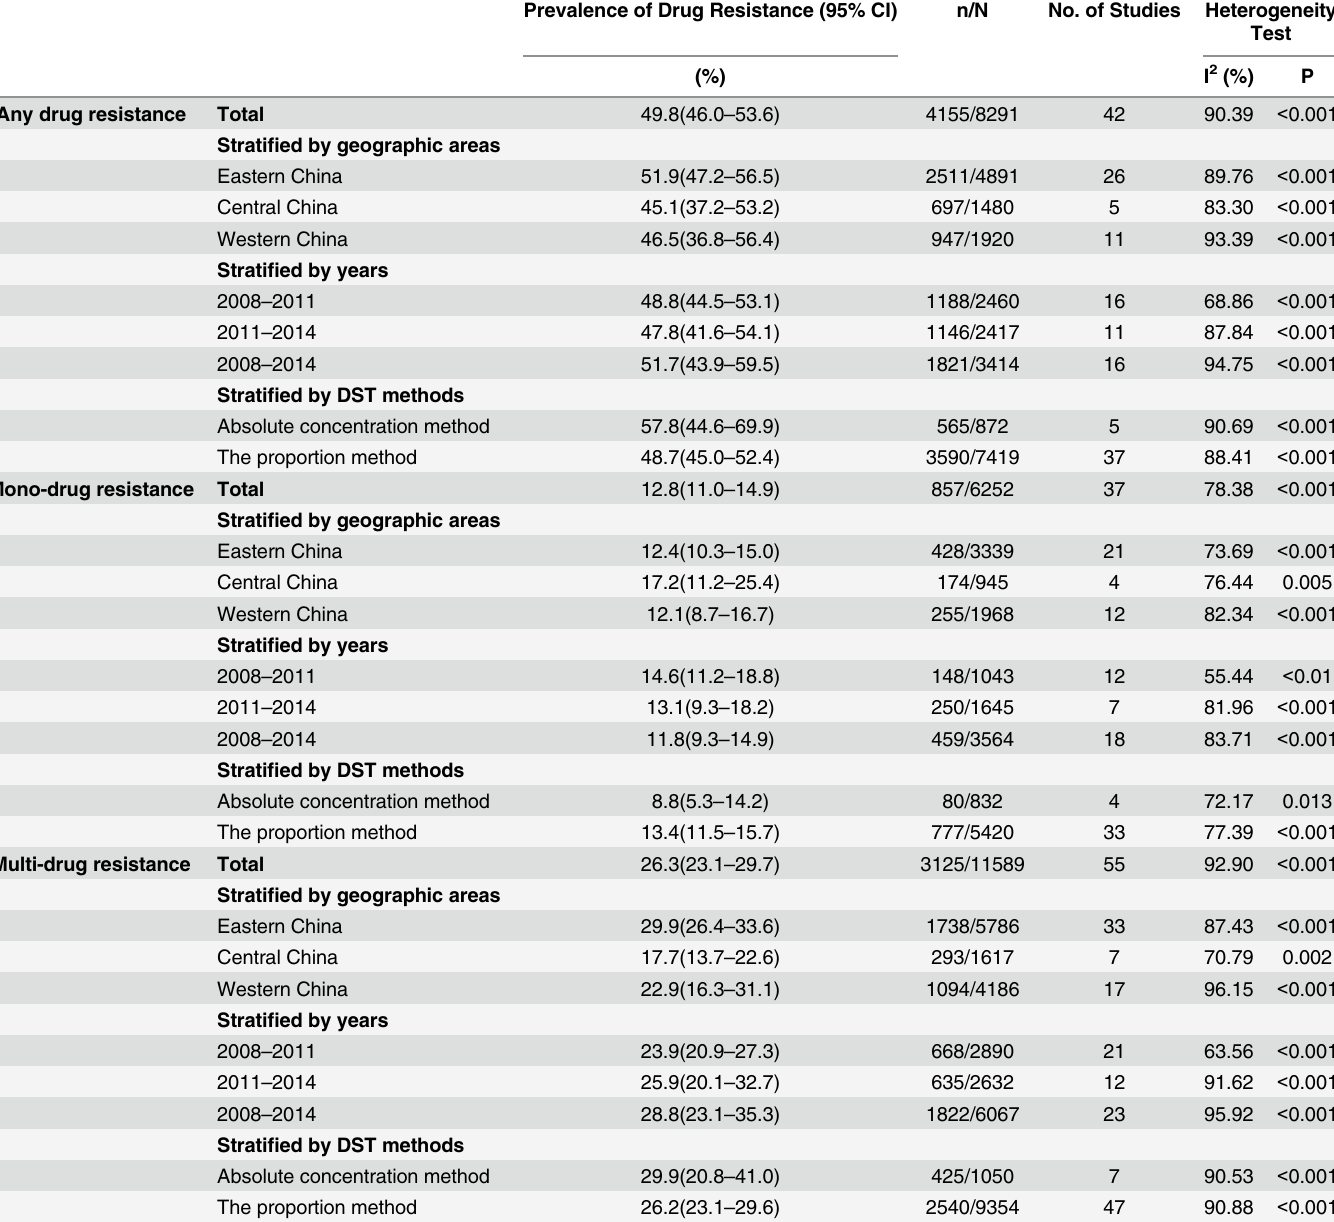
Table 2. Pooled prevalence of drug resistant tuberculosis among retreatment cases in China. Prevalence of Drug Resistance (95% CI)